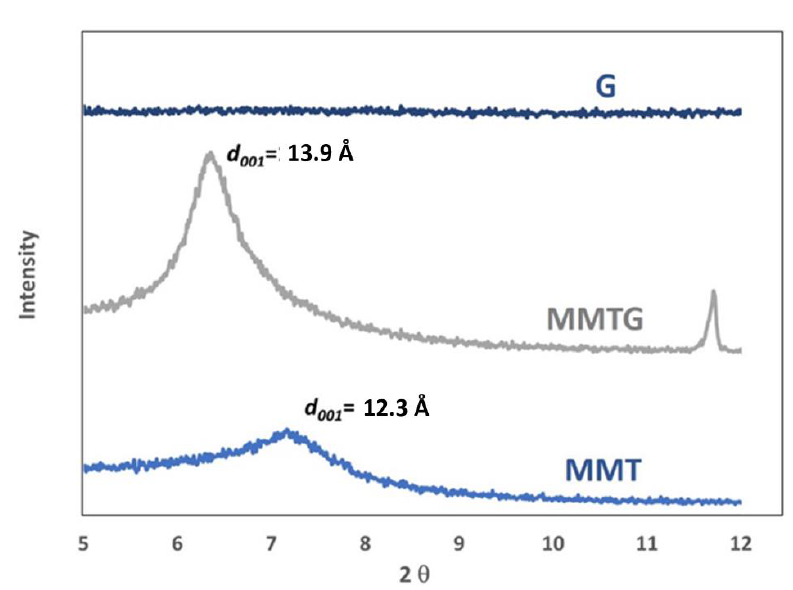
Figure 1. X-ray diffractograms of the tested powders (G, MMT, MMTG). In the measurement range shown, for pure montmorillonite (MMT), one reflex is ob- served at 7.2° of the 2θ angle, which corresponds to an interplanar distance d 001(MMT) equal to 12.3 Å . The calcination of MMT and its subsequent intercalation with gentamicin sulfate (G) leads to a change in the position of the characteristic reflex in the MMTG material and thus a shift towards smaller angles to the position of 6.3°, which corresponds to the value of the interplanar distance d 001(MMTG) equal to 13.9 Å (Table 2). Table 2. The values of the basal interlayer spacing for MMT and MMTG powders calculated based on the position of the main peak.